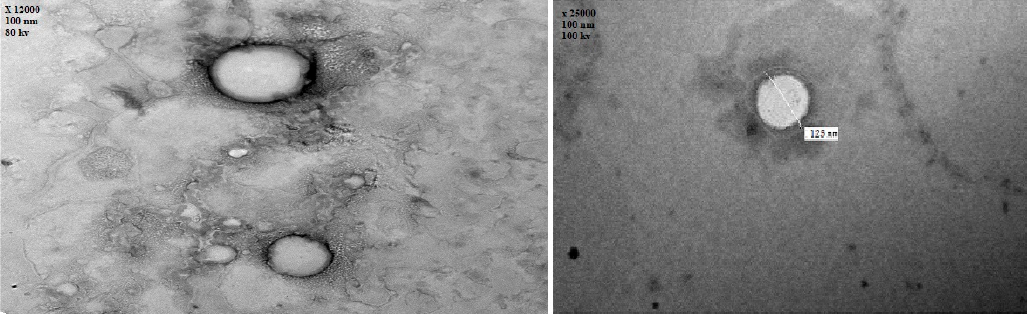
Figure 4. Transmission electron microscope photography of EH emulsomes (×25,000).